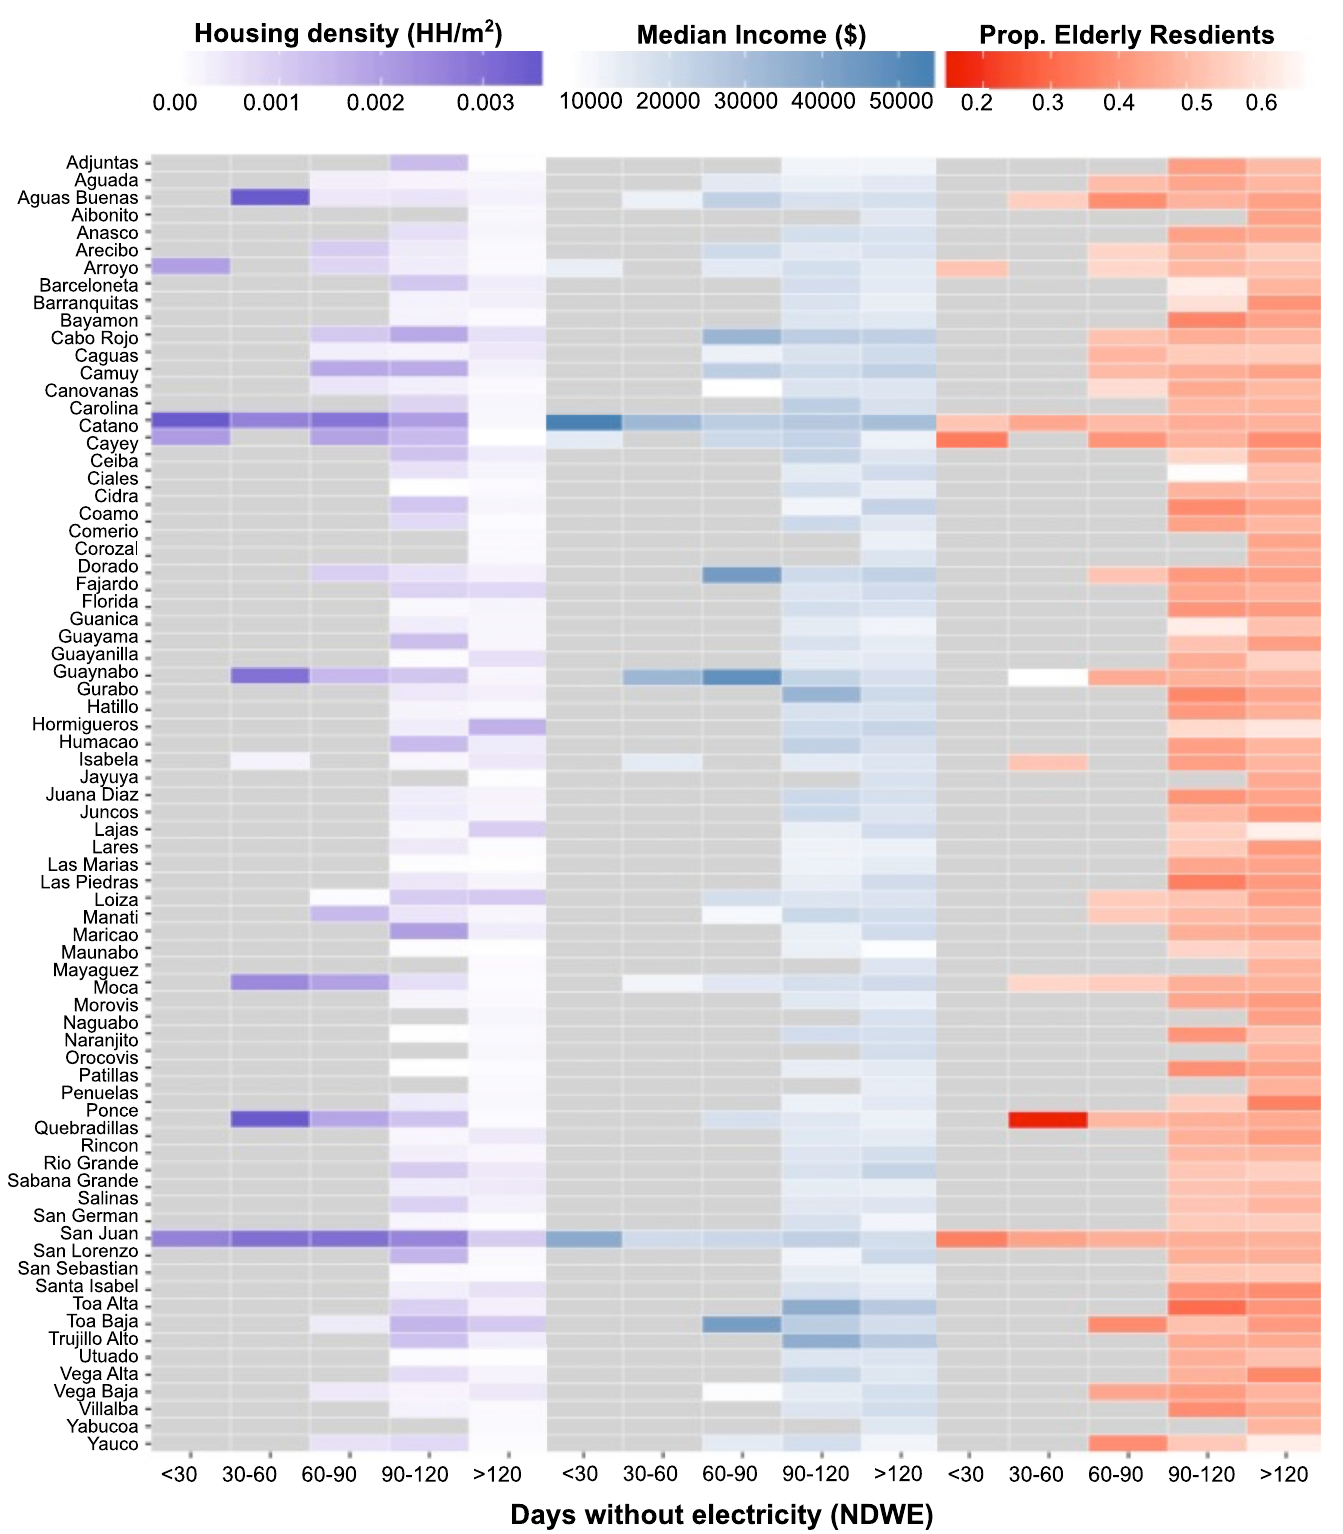
Fig 6. Interaction between demographic vulnerabilities and density-based power restoration protocols. (Left) Housing density (households per square-meter) by recovery rate for all of Puerto Rico’s municipalities. White indicates lower housing densities and dark purple indicates the highest housing densities. Days without